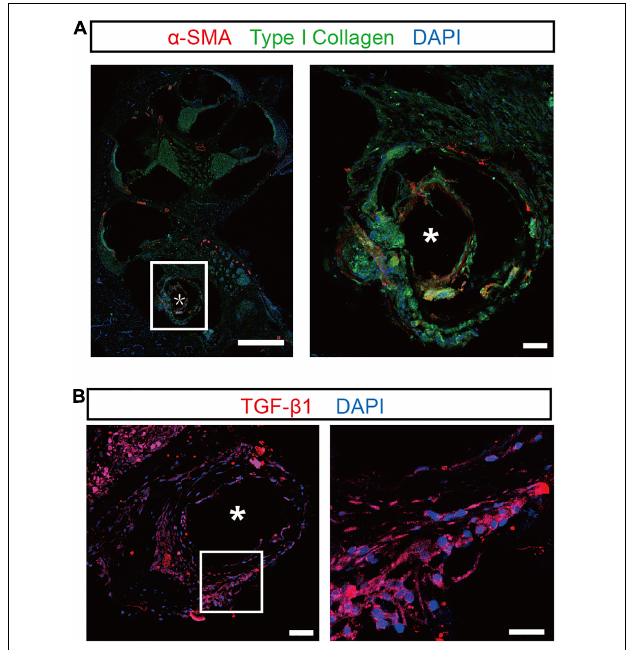
FIGURE 2 | Confocal images of the proliferative tissue after electrode insertion in the cochlea. (A) Representative immunostaining images showing the proliferative tissue in the tympanic scala 5 weeks after implantation. α -SMA (red) and type I collagen (green) were evident in the proliferative tissue (magnified view, right panel). Scale bar = 500 and 50 µ m for the left and right panels, respectively. (B) Left panel: representative immunostaining images showing the expression of TGF- β 1 (red) in the proliferative tissue 5 weeks after implantation. Scale bar = 50 µ m. Right panel: the enlarged plot of the white box in the left panel. Scale bar = 50 µ m. “*” indicates the trajectory of the electrode insertion.